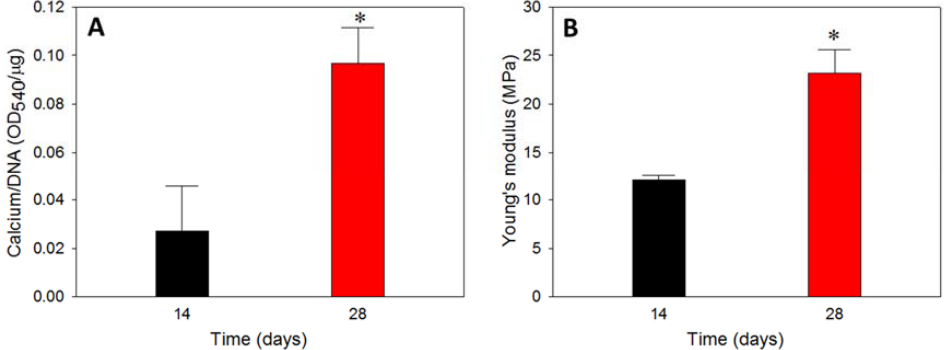
Figure 10. The calcium content ( A ) and Young’s modulus ( B ) of rBMSCs-seeded hybrid scaffolds cultured in vitro for 14 and 28 days. * p < 0.05 compared to day 14.